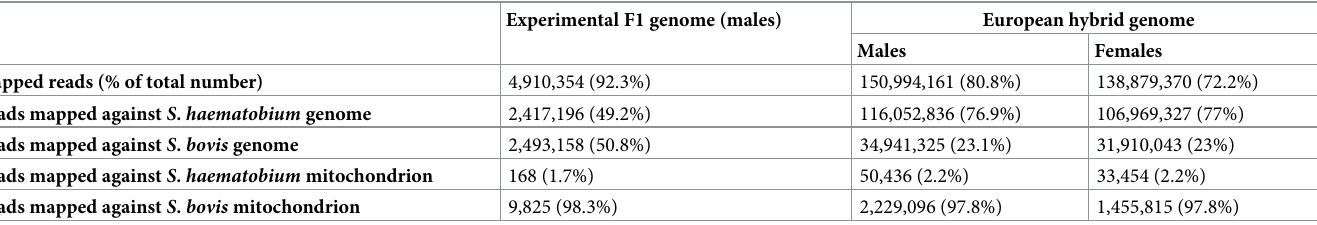
Table 4. Summary of the introgression level analysis of the experimental F1 hybrids (control) and the natural European hybrid strain recovered in Corsica. Experimental F1 genome (males) European hybrid genome Males Females Mapped reads (% of total number) 4,910,354 (92.3%) 150,994,161 (80.8%) 138,879,370 (72.2%) Reads mapped against S . haematobium